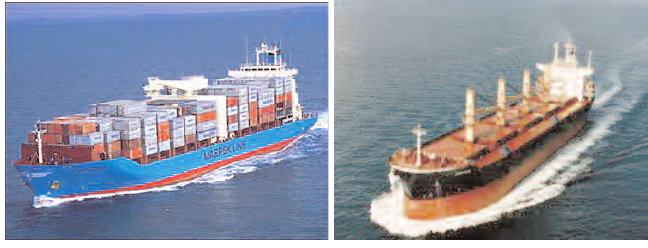
Figure 1. Containership (l) and Bulk Carrier (r) Source: http://www.google.com/imgres